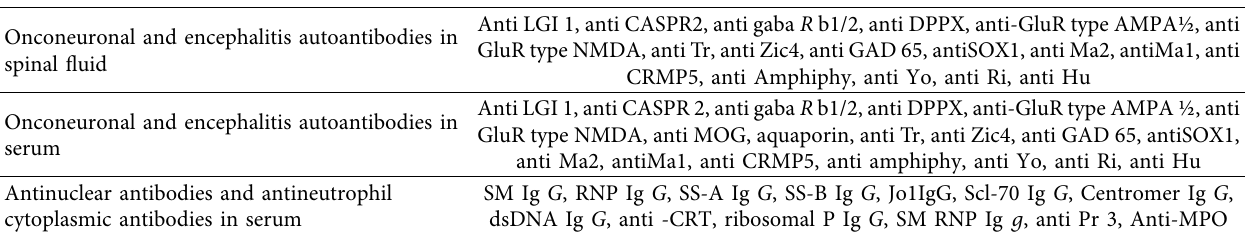
CRMP5, anti Amphiphy, anti Yo, anti Ri, anti Hu